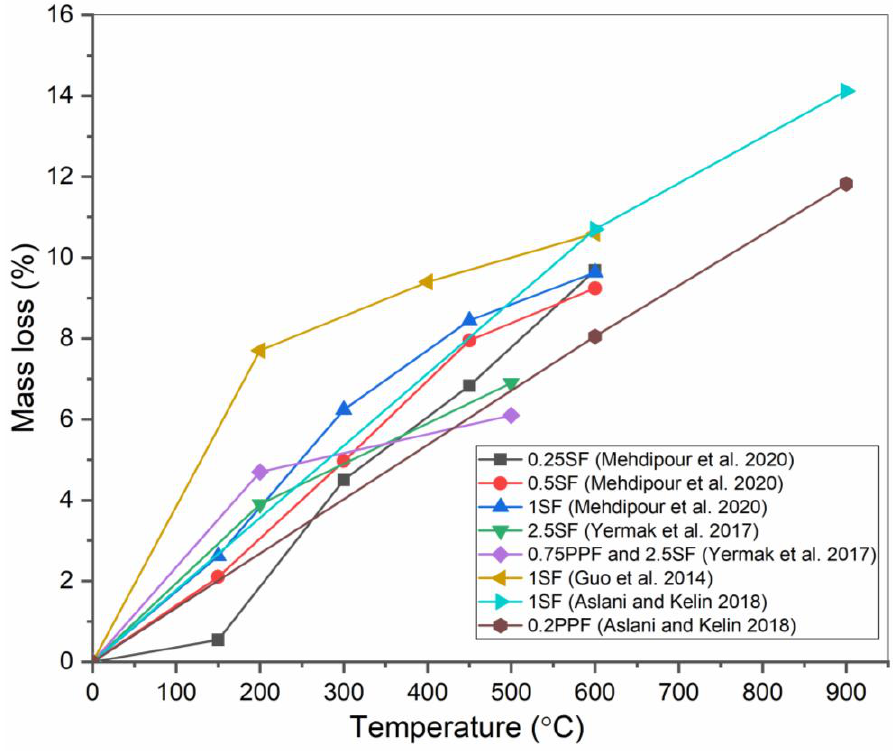
Figure 21. Variations in the mass loss of fiber-reinforced concrete with the increase in temperature